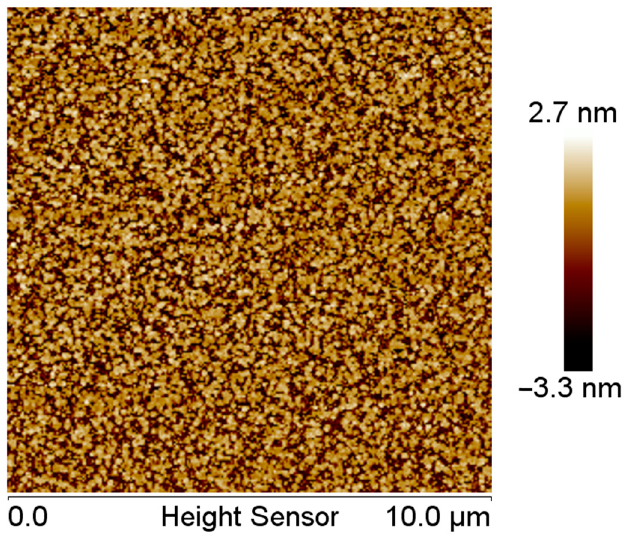
Figure 1. Example of the roughness profile of the test sample no. 1 measured using a Bruker Dimension Edge atomic force microscope (AFM).